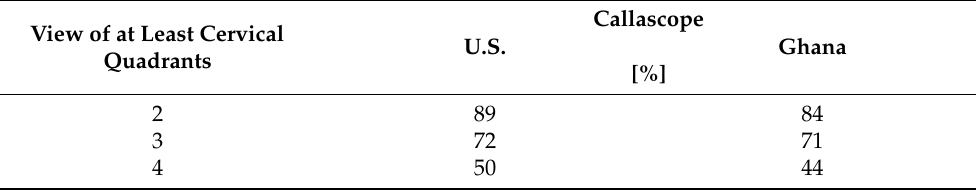
Table 1. Callascope cervical quadrant visualization. View of at Least